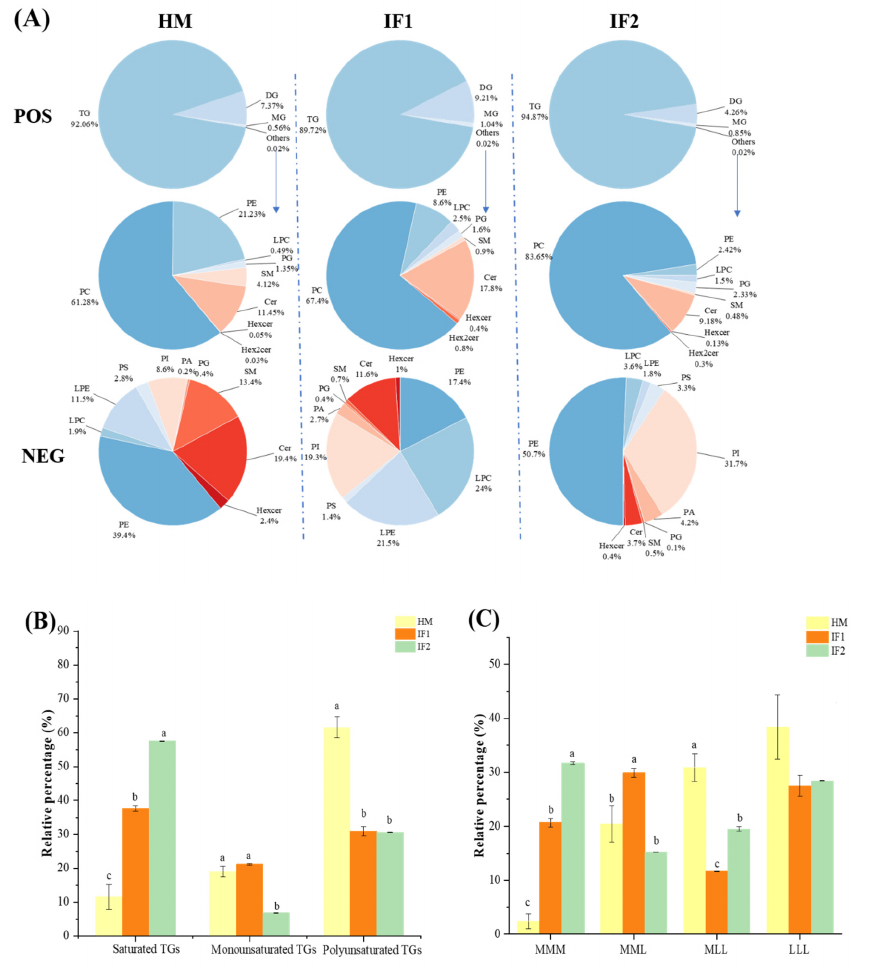
Figure 3. Comparison of percentage content of lipid subclasses among human milk and infant formulas in POS and NEG ion modes ( A ); the distribution of triglycerides in samples on the basis of saturation ( B ); and the distribution of triglycerides in samples on the basis of chain length ( C ). Different lowercase letters indicate significant differences among samples. MMM, three medium-chain fatty acids triglyceride; MML, two medium-chain and one long-chain fatty acids triglyceride; MLL, one medium-chain and two long-chain fatty acids triglyceride; LLL, three long-chain fatty acids triglyceride.